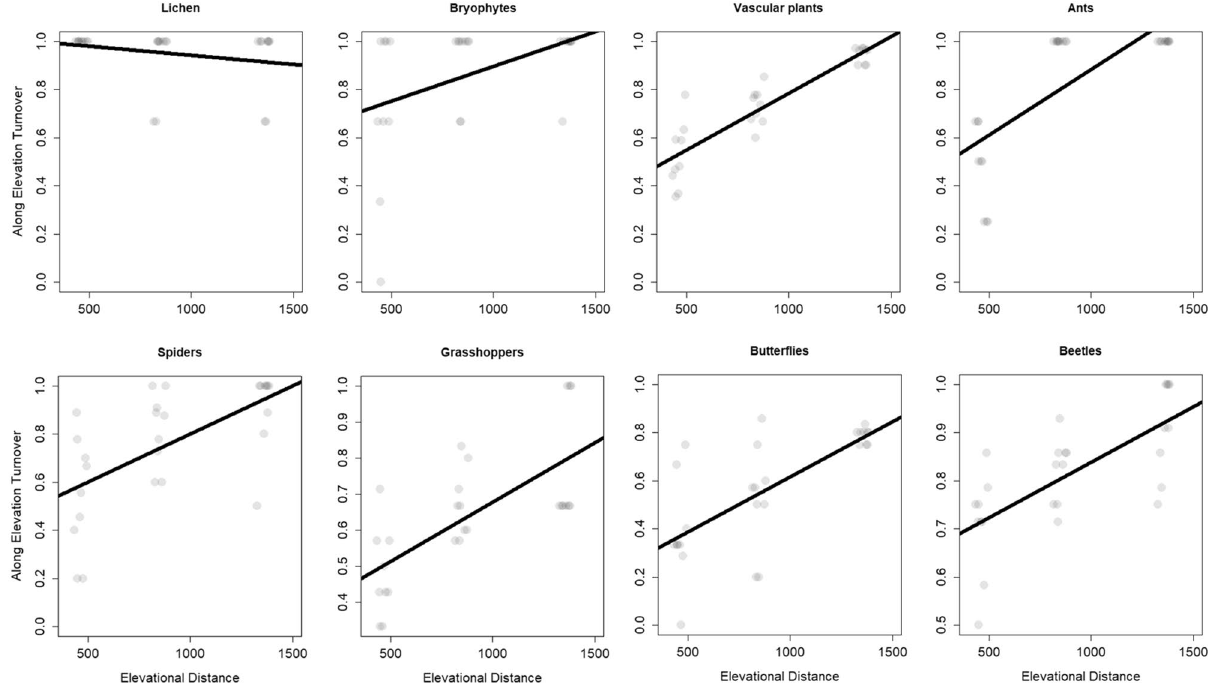
Figure 3. Along elevational turnover: the effect of elevational distance on turnover was tested with a linear mixed effects model. As fixed effects, we tested the elevational distance, as random effects the elevational replicate sites were modelled. The line indicates the response of turnover to elevational distance, grey points display turnover values of pair-wise comparisons. Figure was produced using R software (version 3.6.2, R Core Team, https ://www.r-proje ct.org/).